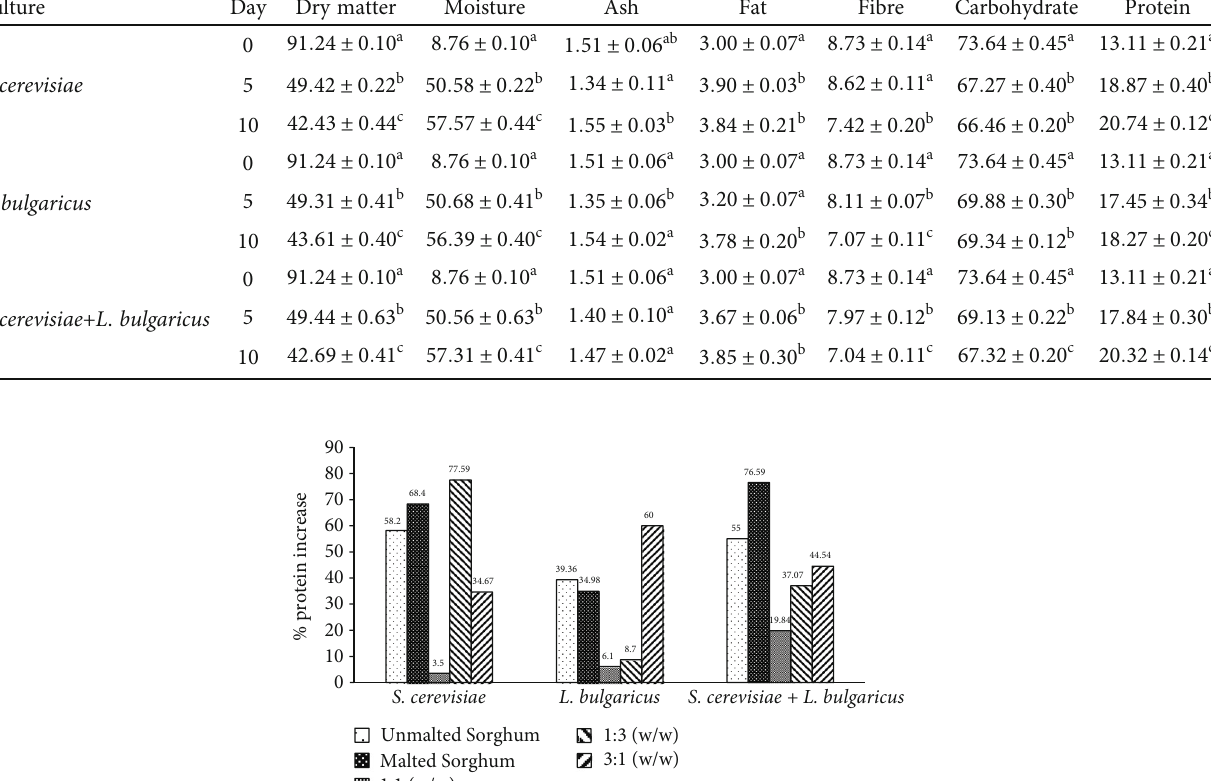
Figure 3: Percentage (%) increase in protein contents of malted and unmalted sorghum and their formulated blends after 10 days of